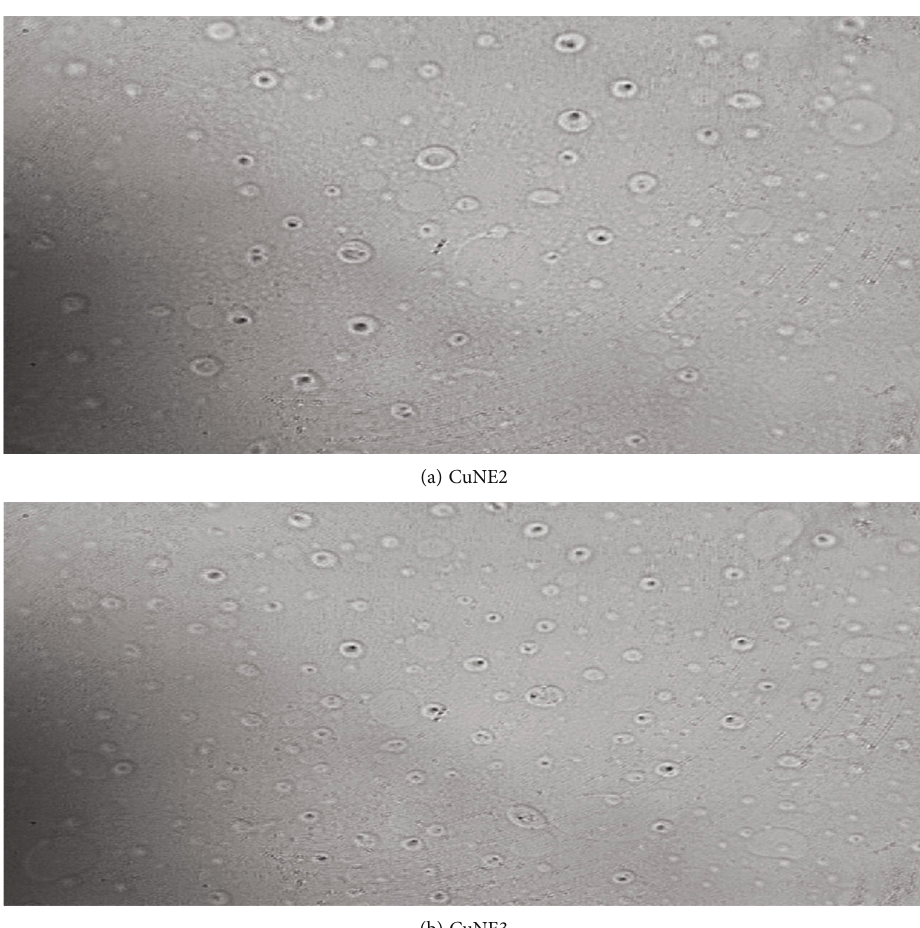
Figure 3: Optical image for curcumin encapsulation in di ff erent nanoemulsion samples.